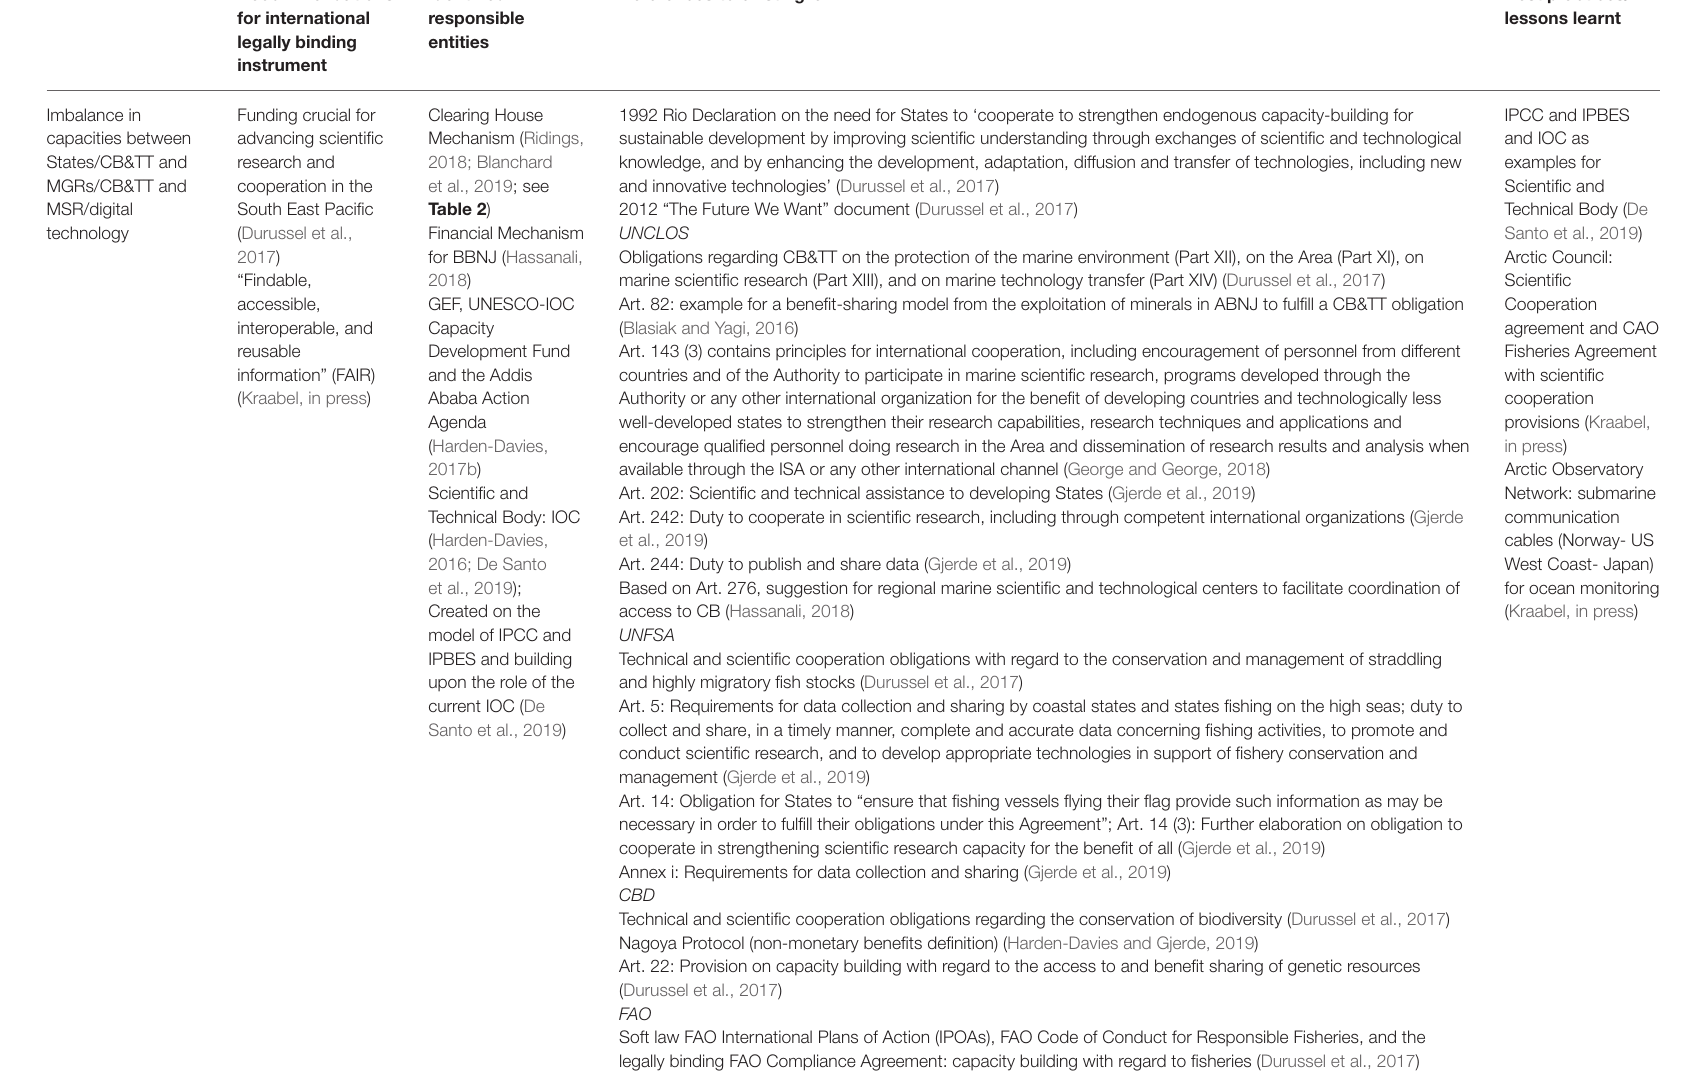
Best practices/ lessons learnt